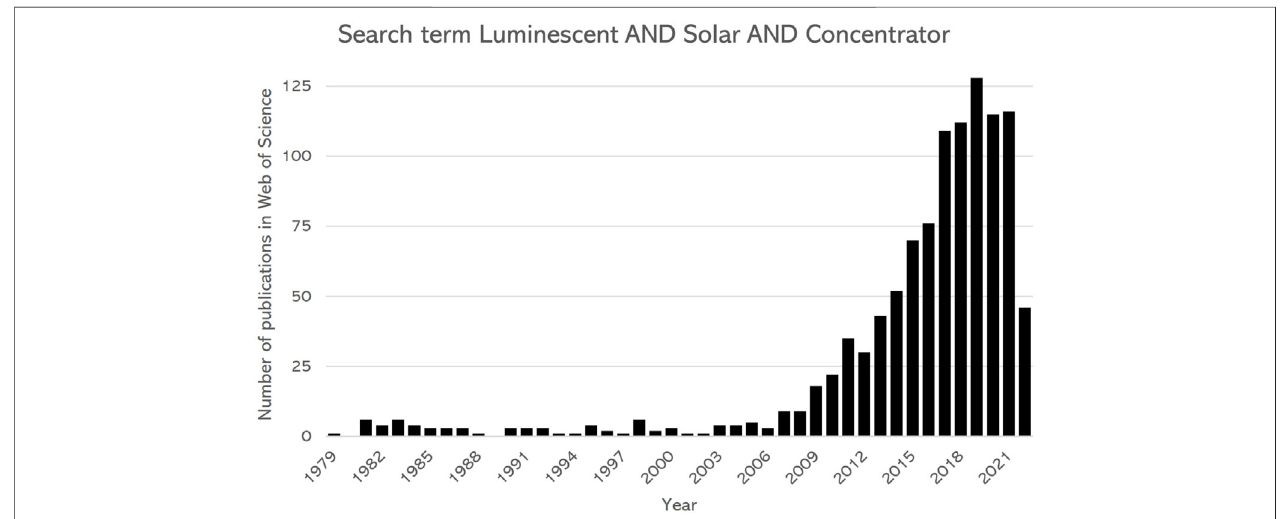
FIGURE 2 | Number of publications per year as found in Web of Science on LSCs, using the search term “ Luminescent ” AND “ Solar ” AND “ Concentrator ” , since 1979. Data collected 7 June 2022.